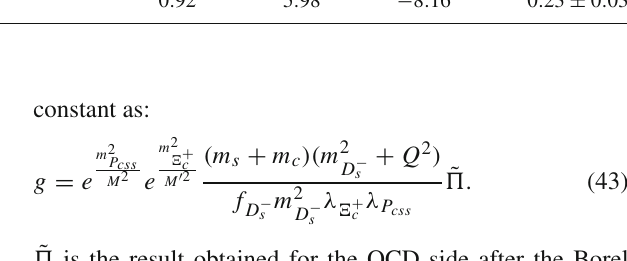
Table 2 Values of the Decay parameters for the fit functions of coupling constants, g 1 and g 2 for P css → (cid:2) 0 J /ψ decay and and g for P css → (cid:2) + c D − s decay and their values obtained from the fit functions at Q 2 = − m 2 J /ψ and Q 2 = − m 2 , respectively D − s